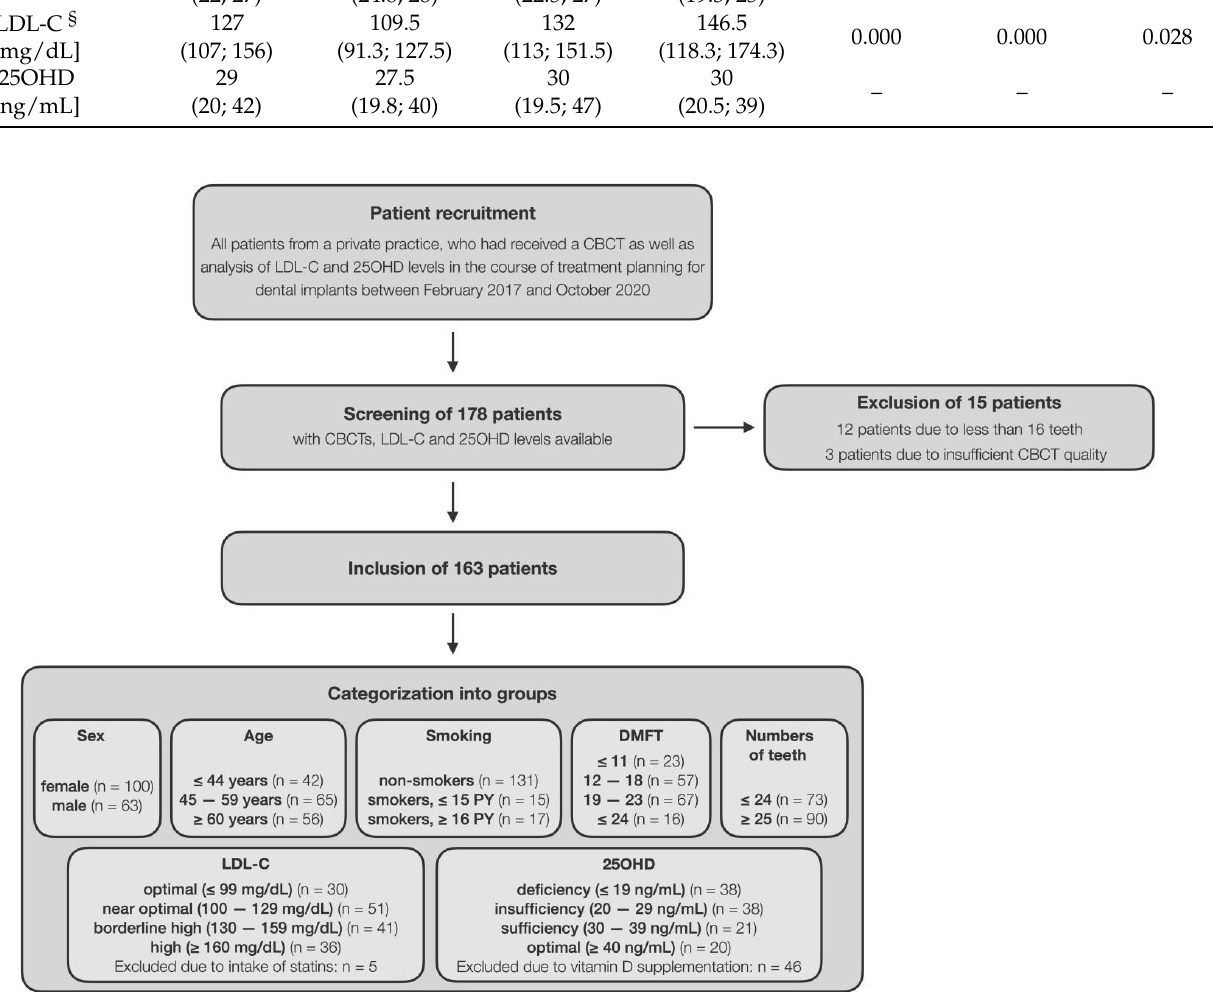
samples was 15 (1; 50) days. Figure 2 shows the flow of patients through the stages of this study.